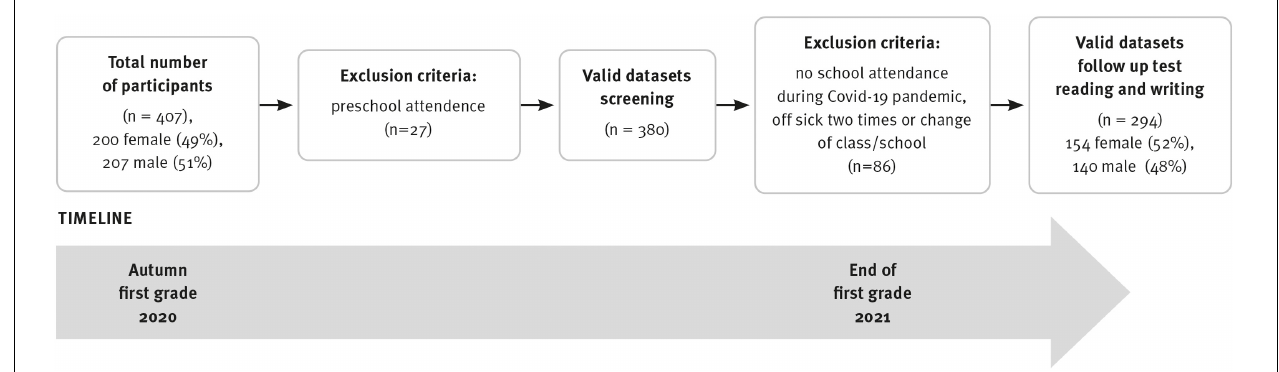
FIGURE 1 | Recruitment pathways and